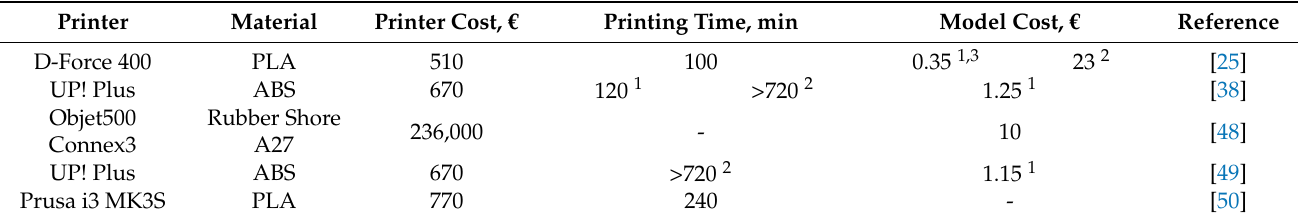
Table 6. Comparison of the literature results in terms of printing time and printing cost for the reproduction of cere- bral aneurysms.